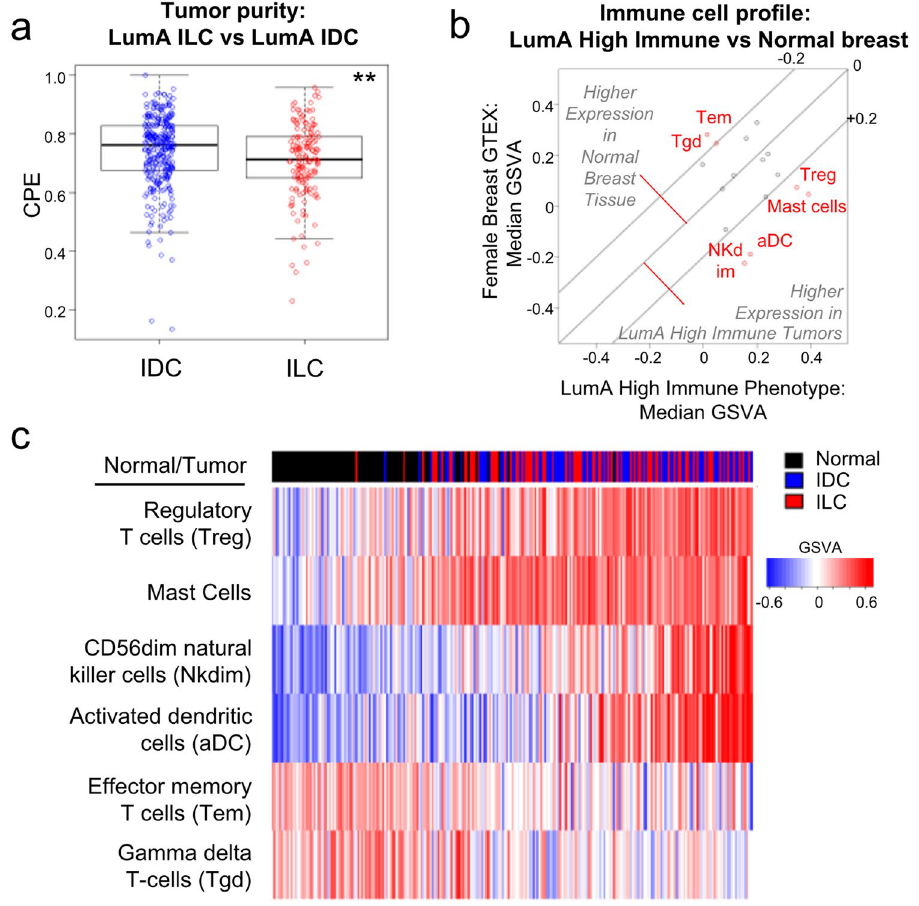
Figure 2. Immune signature difference is not a reflection of normal breast contamination. ( a ) Tumor purity score (CPE) of LumA ILC (n = 157) and LumA IDC (n = 307). Mann-Whitney U test, ** p < 0.005. ( b ) LumA high immune tumors (n = 162) have different immune cell profile than normal female breast tissue (n = 90). Immune cell types with median GSVA difference > 0.2 between normal breast tissue and LumA high immune tumors are marked in red: CD56dim Natural Killer cells (NK dim), activated dendritic cells (aDC), effector memory T-cells (Tem), gamma delta T-cells (Tgd). ( c ) Tumors and normal breast can be differentiated based on immune cell expression. Tumors/normal breast tissues in heatmap were sorted by sum (Treg + mast_ cell + Nkdim + aDC) – sum(Tem,